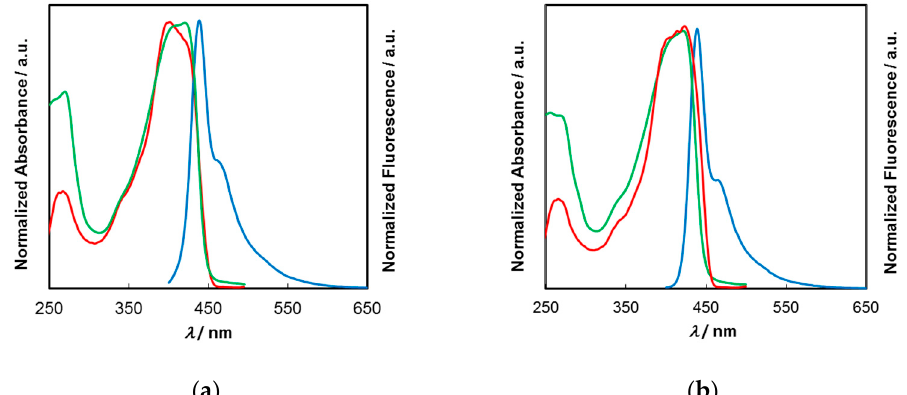
Figure 1. Absorption (green line), excitation (red line, monitored at emission maxima) and emission (blue line) spectra ( λ exc = 380 nm, CHCl 3 ) of polymer 4 ( a ) and polymer 5 ( b